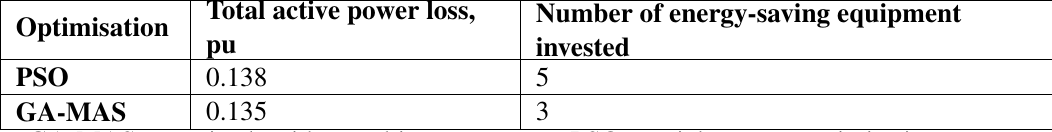
Table 2 Comparison of active power loss of different optimisation algorithms